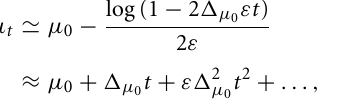
= 1). Bottom: the 0 0